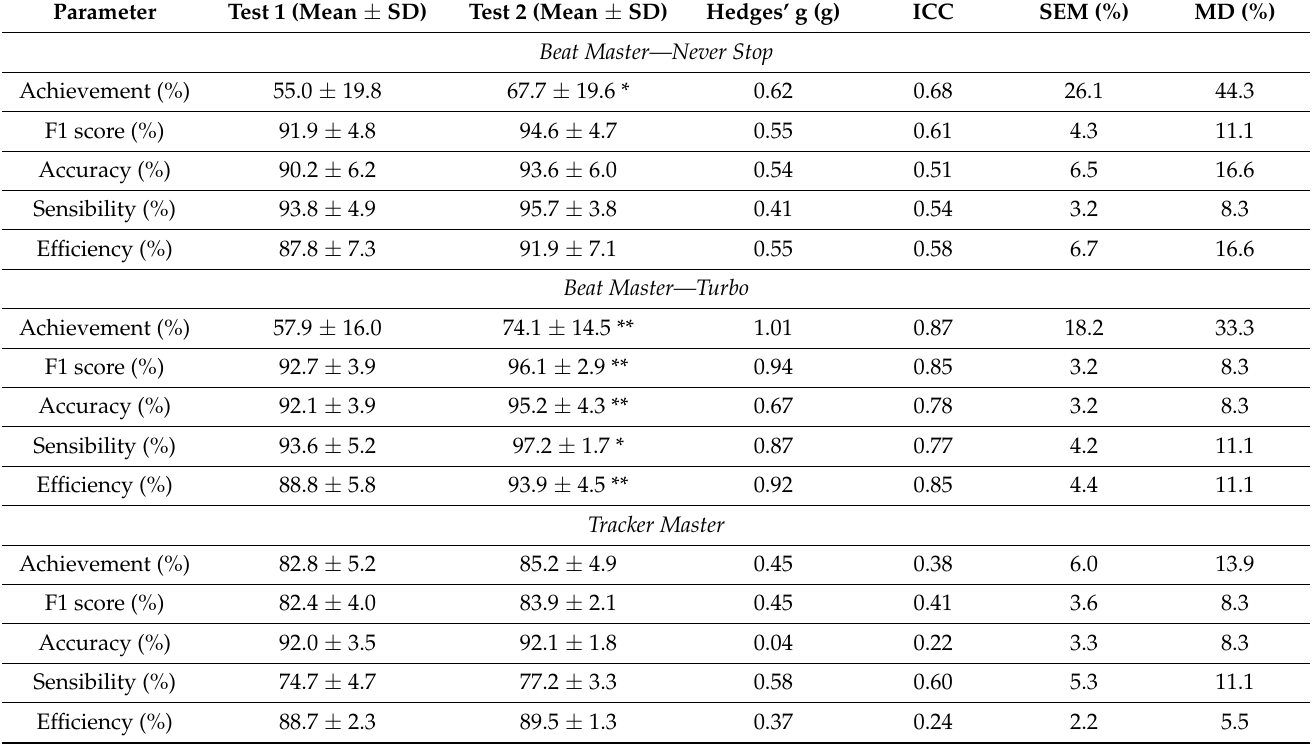
Table 1. Reliability of the scores provided by the virtual reality device during the